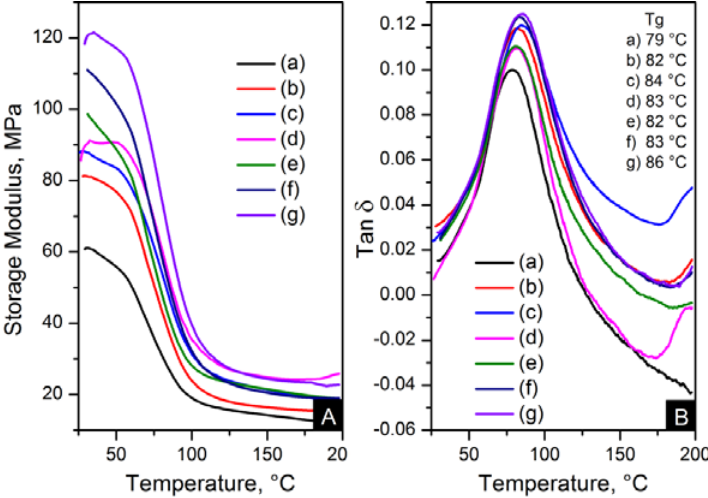
( B ) Tan δ of: ( a ) pure PA66; ( b ) PA66/01CNTs; ( c ) PA66/05CNTs; ( d ) PA66/10CNTs; ( e ) PA66/01OCNTs; ( f ) PA66/05OCNTs and ( g ) PA66/10OCNTs.